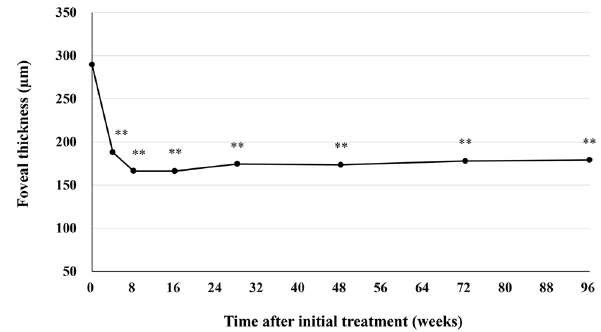
Figure 2. Change of foveal thickness in 43 eyes with neovascular age-related macular degeneration associated with type 1 macular neovascularization treated with 3 monthly intravitreal injections of brolucizumab followed by a treat-and-extend regimen with intravitreal brolucizumab. The significant reduction of foveal thickness in the first year was sustained in the second year. (** P < 0.01). Data are expressed as averages. Values at weeks 28, 48, 72, and 96 represent the averages of the values at weeks 24 and 28, 48 ± 4, 72 ± 4, and 84–96, respectively.